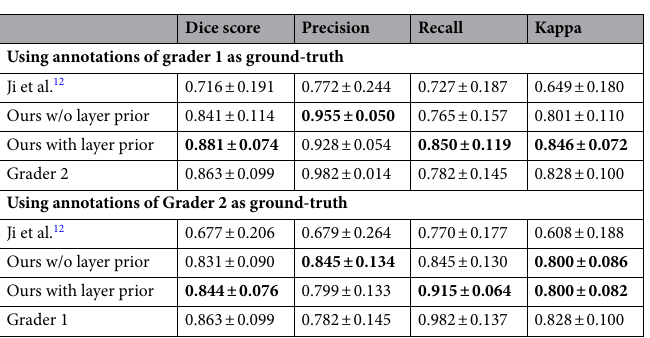
Table 2. Mean performance metrics of the convolutional neural network (CNN) and graders on the separate test set. Bold indicates the best performance values per evaluation parameter.